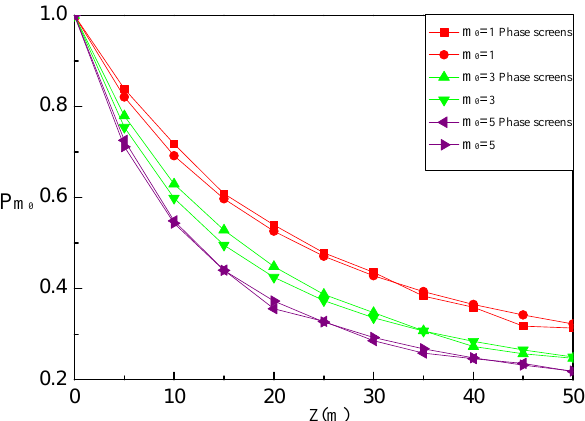
Figure 4. Detection probability P m parameter of topological charge m 0 .